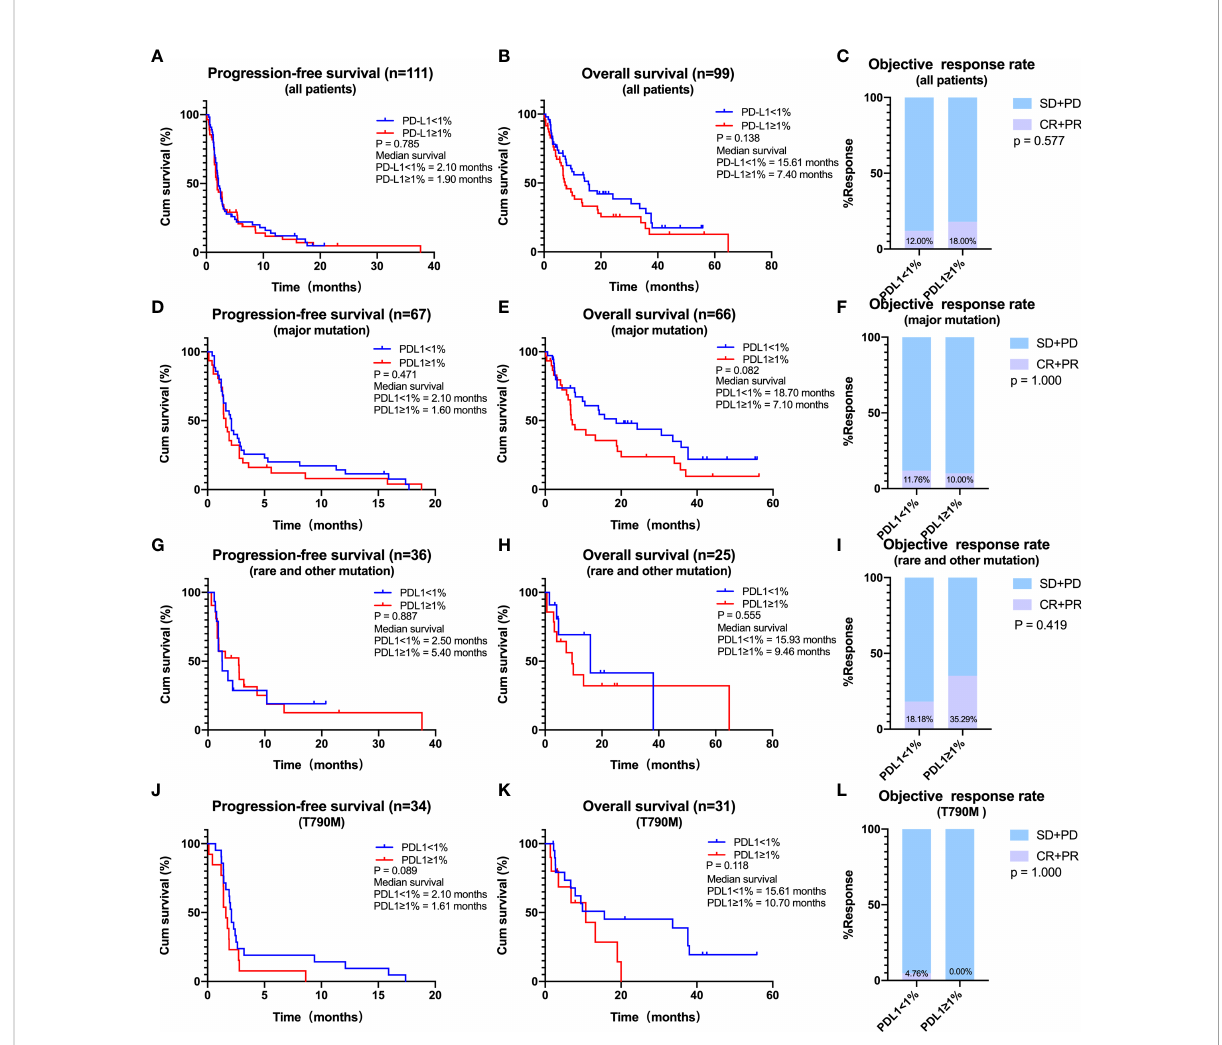
FIGURE 3 Effects of programmed cell death ligand 1 (PD-L1) expression on the ef fi cacy of immune checkpoint inhibitors (ICIs). (A – C) The effect of PD-L1 expression (PD-L1 < 1% vs . PD-L1 ≥ 1%) on the progression-free survival (PFS) (A) , overall survival (OS) (B) , and objective response rate (ORR) (C) for all patients receiving ICIs. (D – F) The effect of PD-L1 expression (PD-L1 < 1% vs . PD-L1 ≥ 1%) on the PFS (D) , OS (E) , and ORR (F) for patients with major mutations receiving ICIs. (G – I) The effect of PD-L1 expression (PD-L1 < 1% vs . PD-L1 ≥ 1%) on the PFS (G) , OS (H) , and ORR (I) for patients with rare or other mutations receiving ICIs. (J – L) , The effect of PD-L1 expression (PD-L1 < 1% vs . PD-L1 ≥ 1%) on the PFS (J) , OS (K) , and ORR (L) for patients with T790M receiving